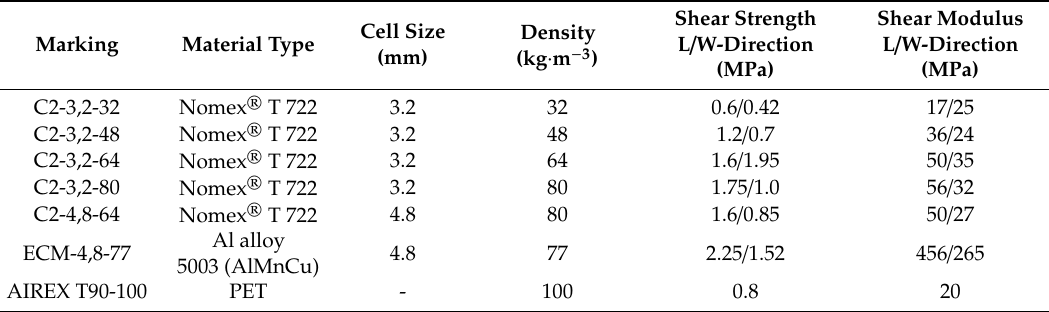
Figure 1. Honeycomb design. Table 2. Material characteristics of core materials.